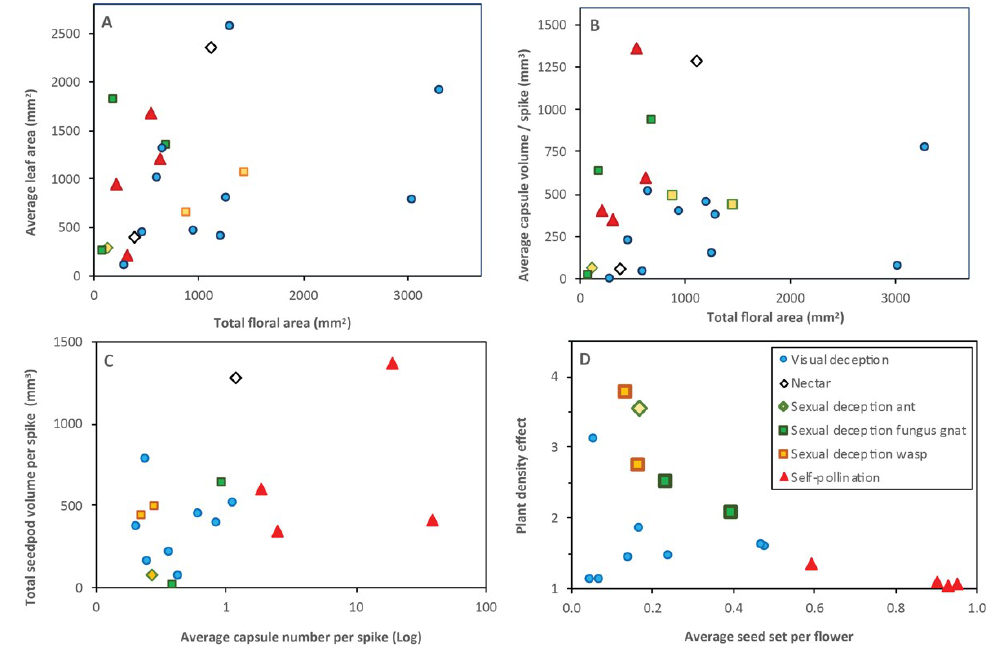
Figure 10. Average fruit set rates for species and years sampled separated into pollination trait groups.